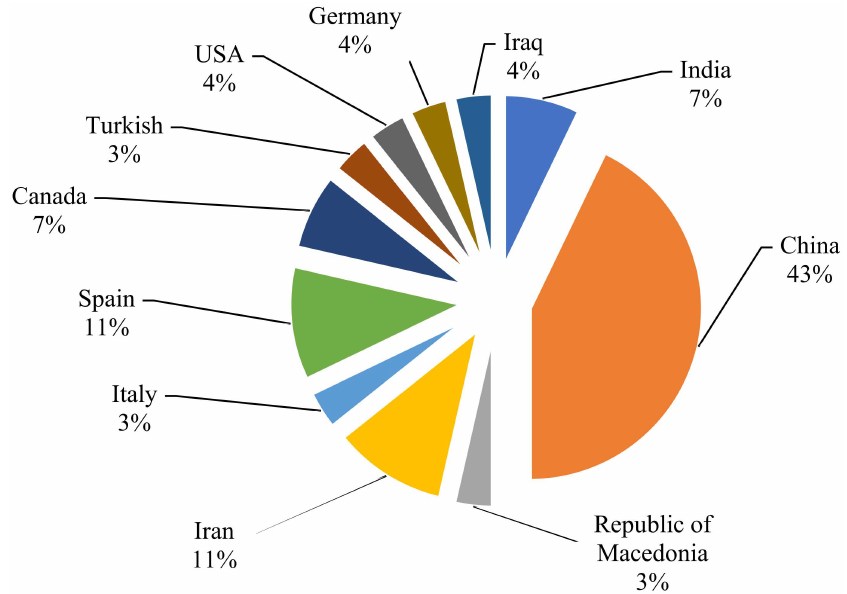
Figure 2. An overview of the countries that determined the residual amounts of pesticides in grapes in